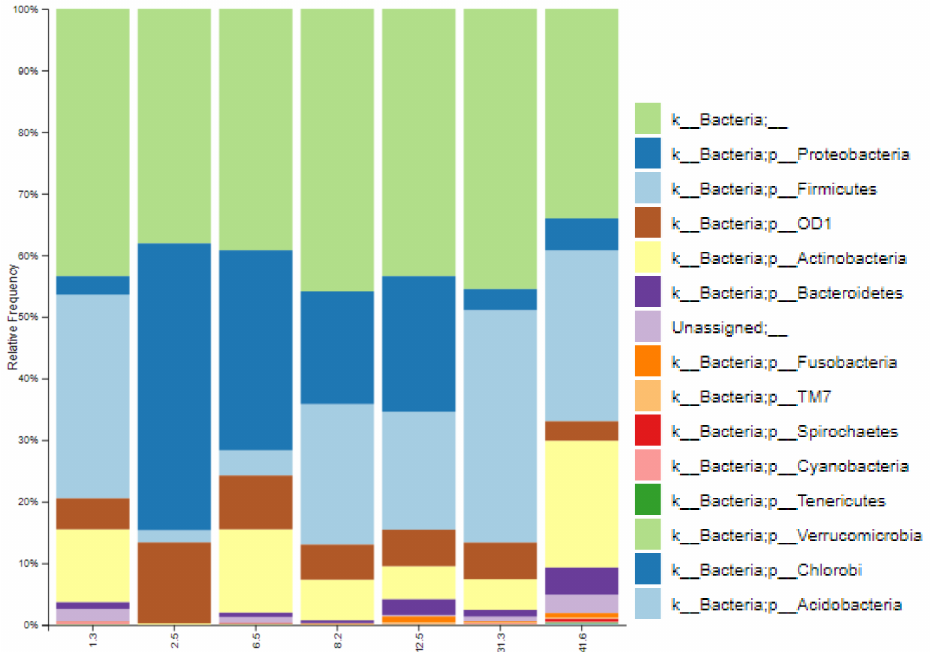
Figure 1. Stacked bar graph showing relative abundances of bacterial phyla in breast milk of healthy Spanish mothers, determined using 16S rRNA amplicon sequencing. The category axis describes the moment of lactation (in months) of each